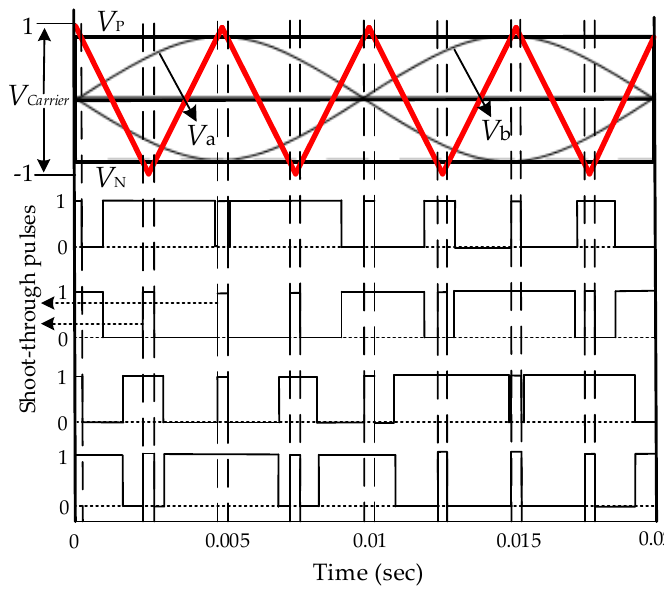
Figure 5. Shoot-through control signal waveforms for the SL-SBZSI.